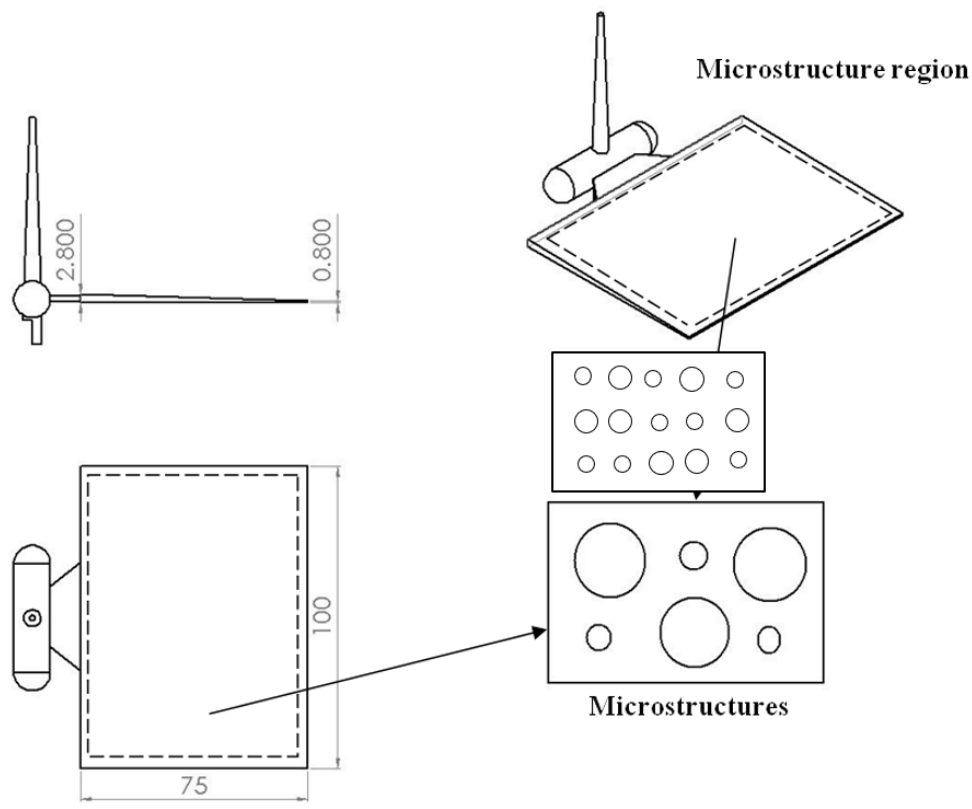
Figure 1. The dimensions of light guide plate. (unit: mm).